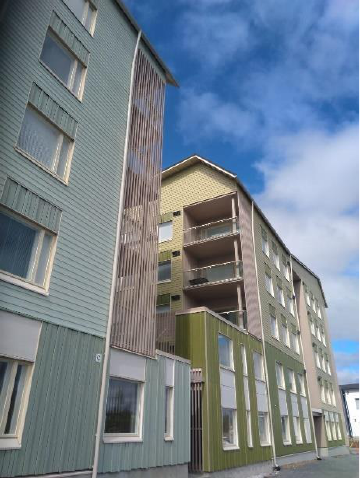
Figure 11. TA Aihkinkatu 6/Honkakuusenkatu 5, Isokuusi: ( a ) exterior view; ( b , c ) interior views (photos courtesy of Suomen metsäkeskus).